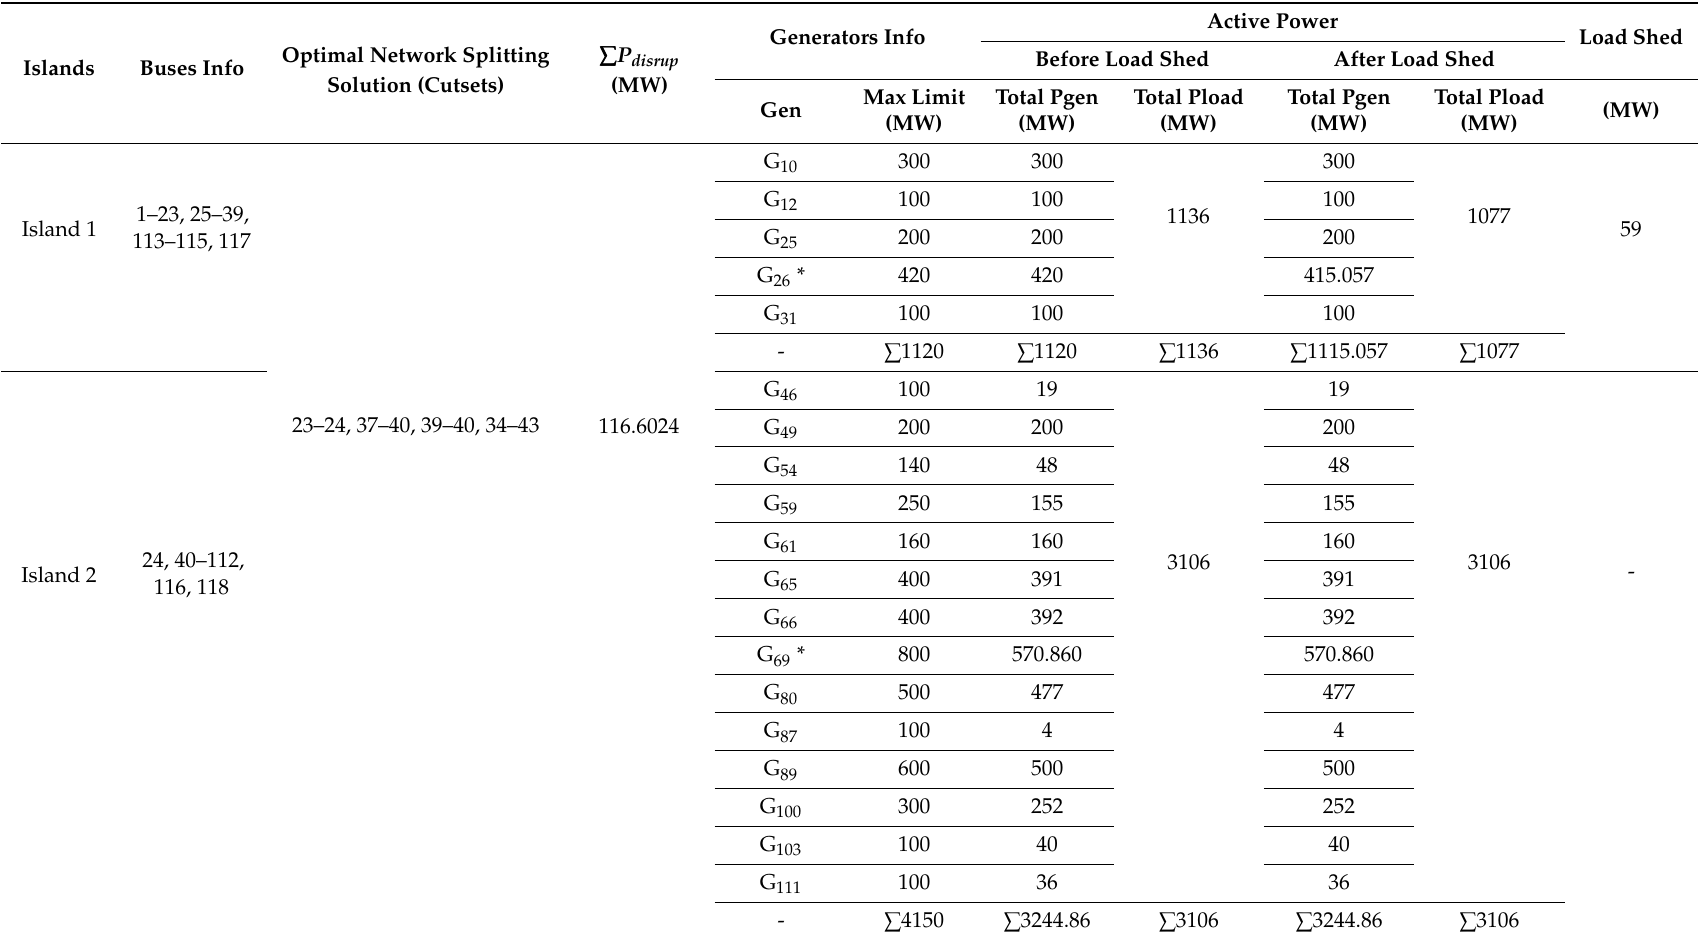
Table 7. IEEE 118 data after network splitting for Case